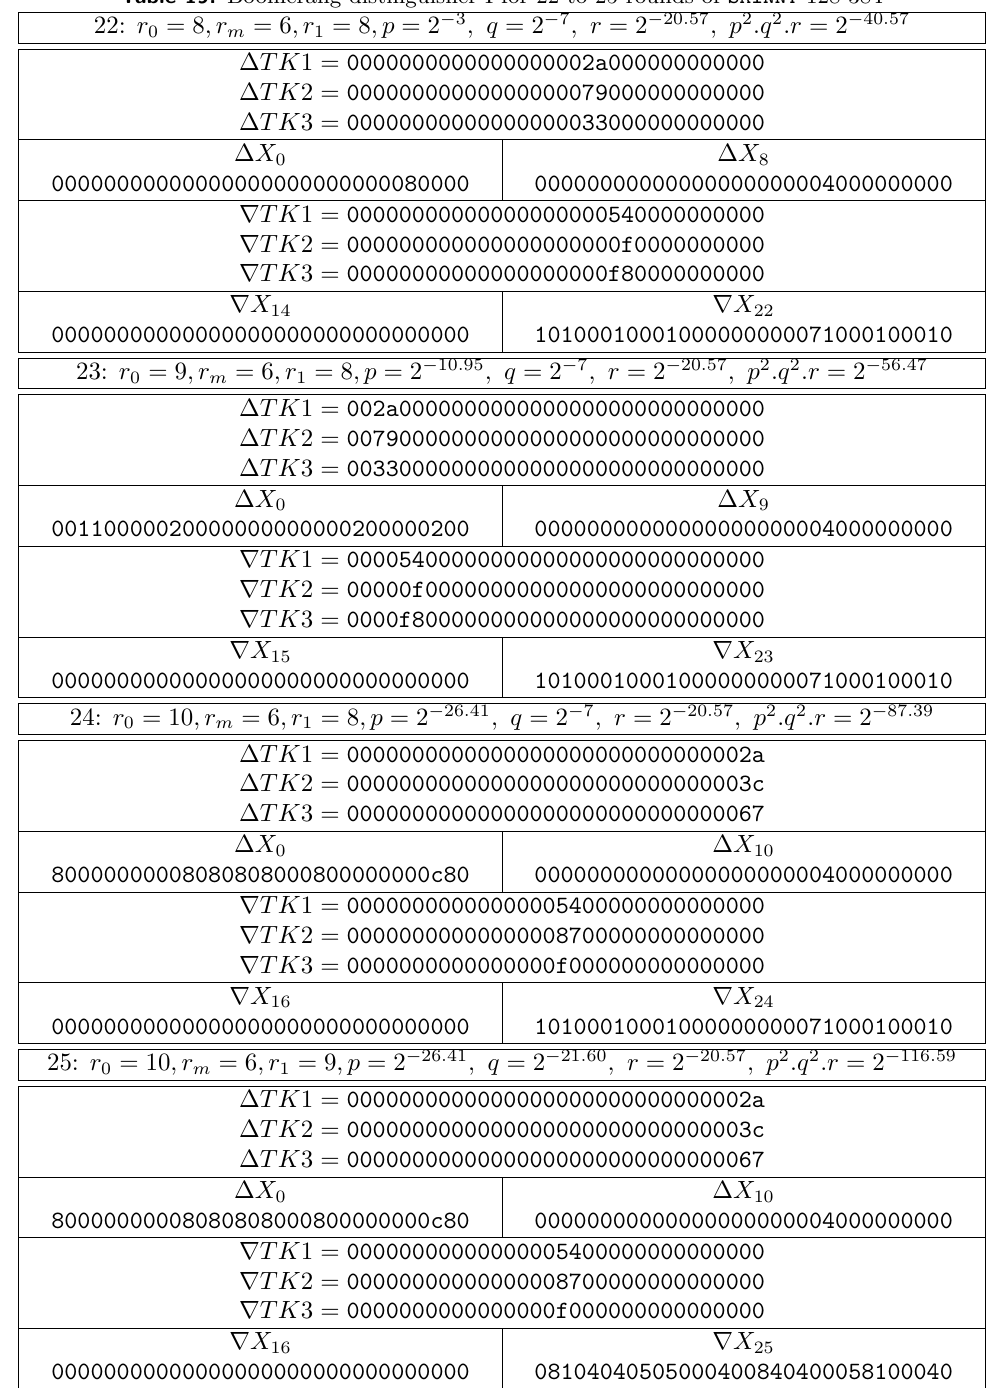
Table 19: Boomerang distinguisher I for 22 to 25 rounds of SKINNY